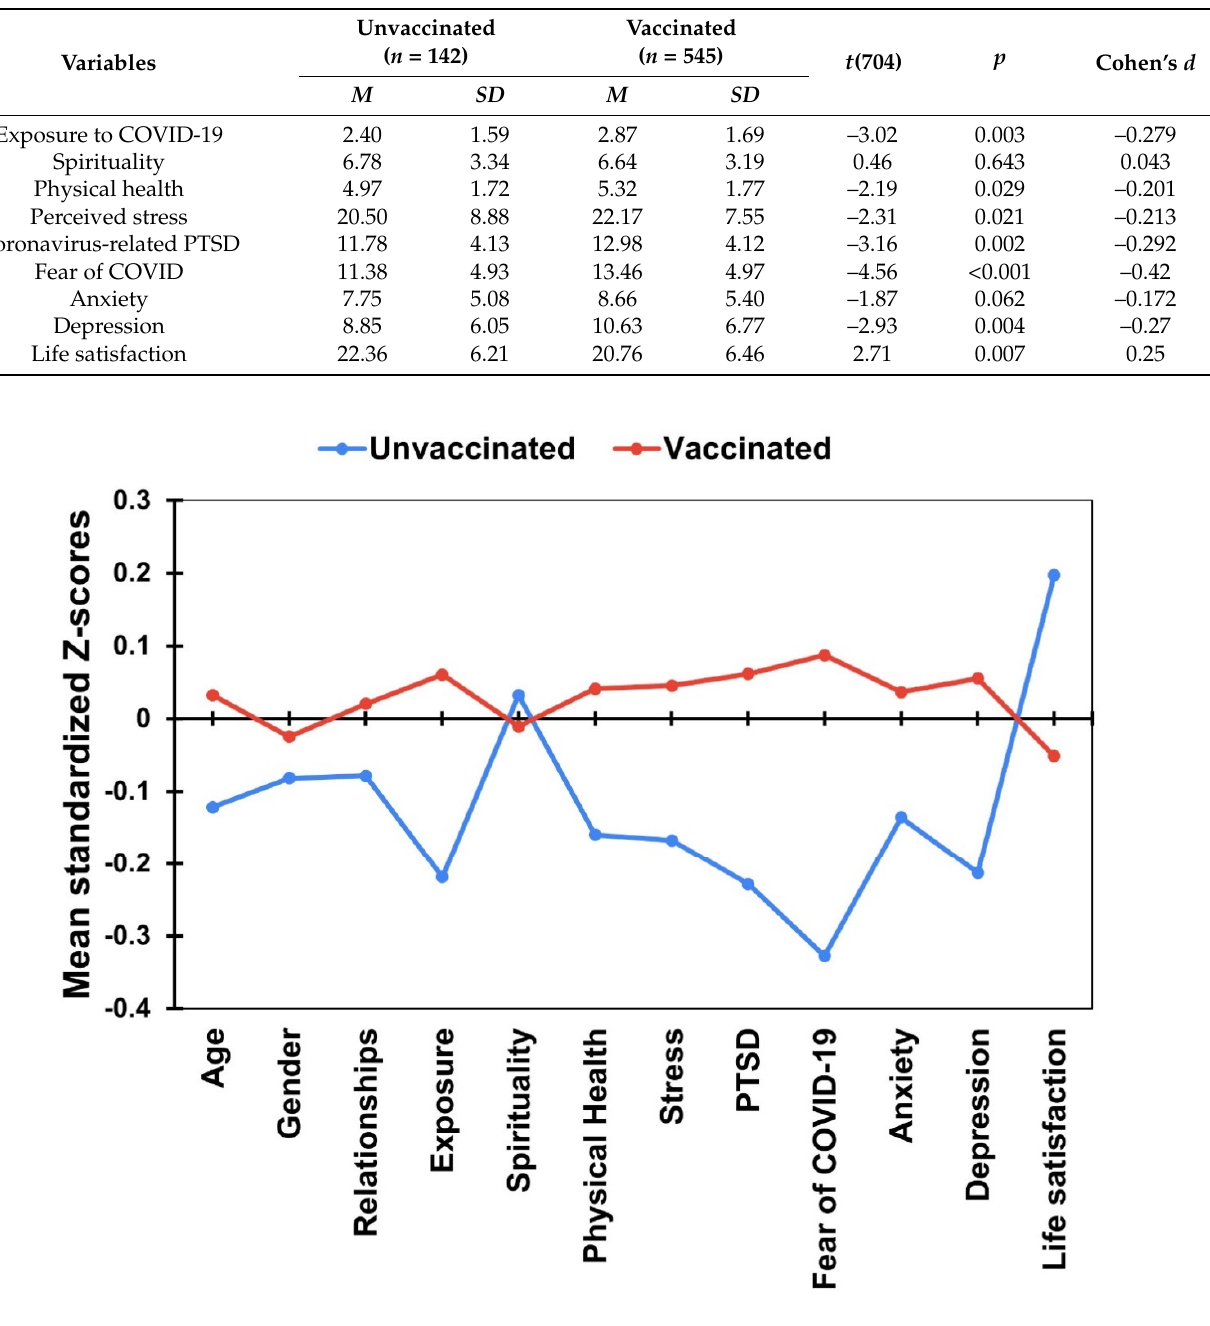
Figure 1. Differences between vaccinated and unvaccinated participants in mean standardized Z-scores of demographic variables and well-being dimensions.